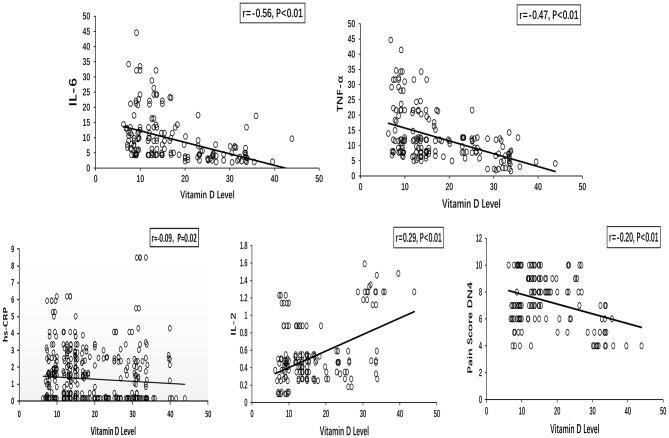
Spearman correlations between vitamin D level and inflammatory cytokines (IL-6, TNF-α, hs-CRP, and IL-2), pain score DN4 in painful DPN group. DPN, diabetic peripheral neuropathy.